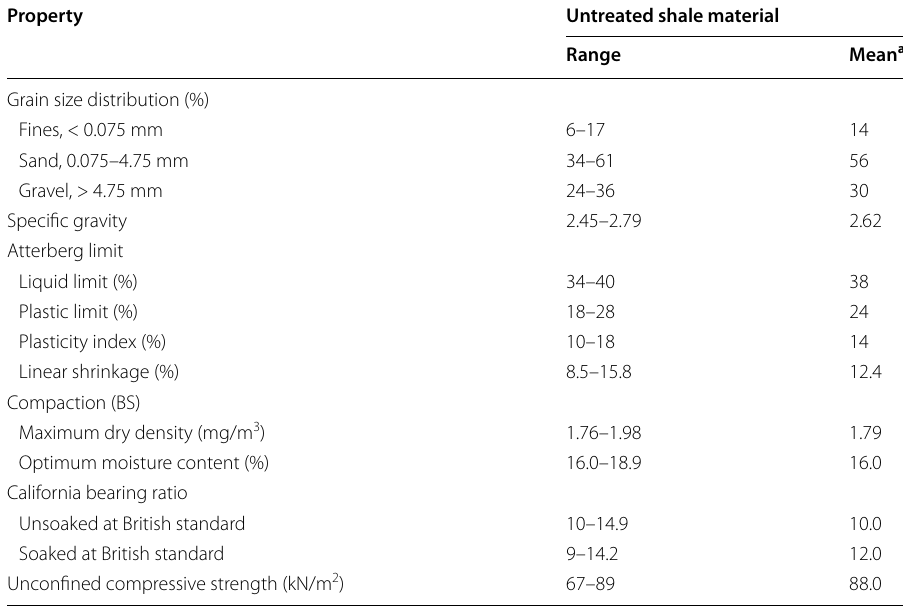
Table 2 Index properties of the untreated shale